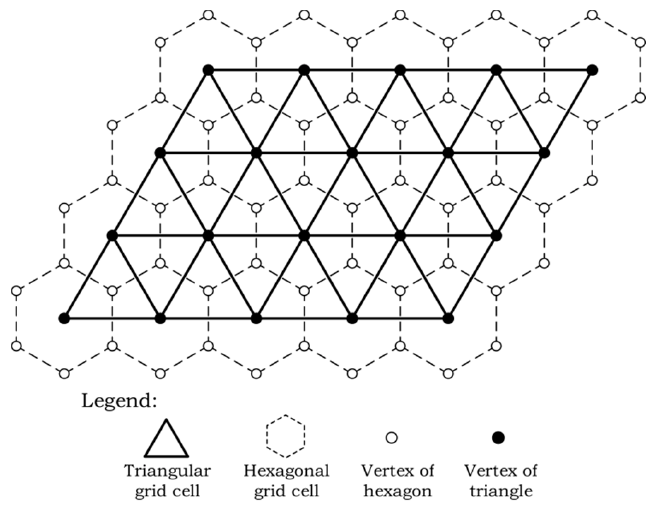
Figure 1. Duality relationship between hexagonal and triangular grids.